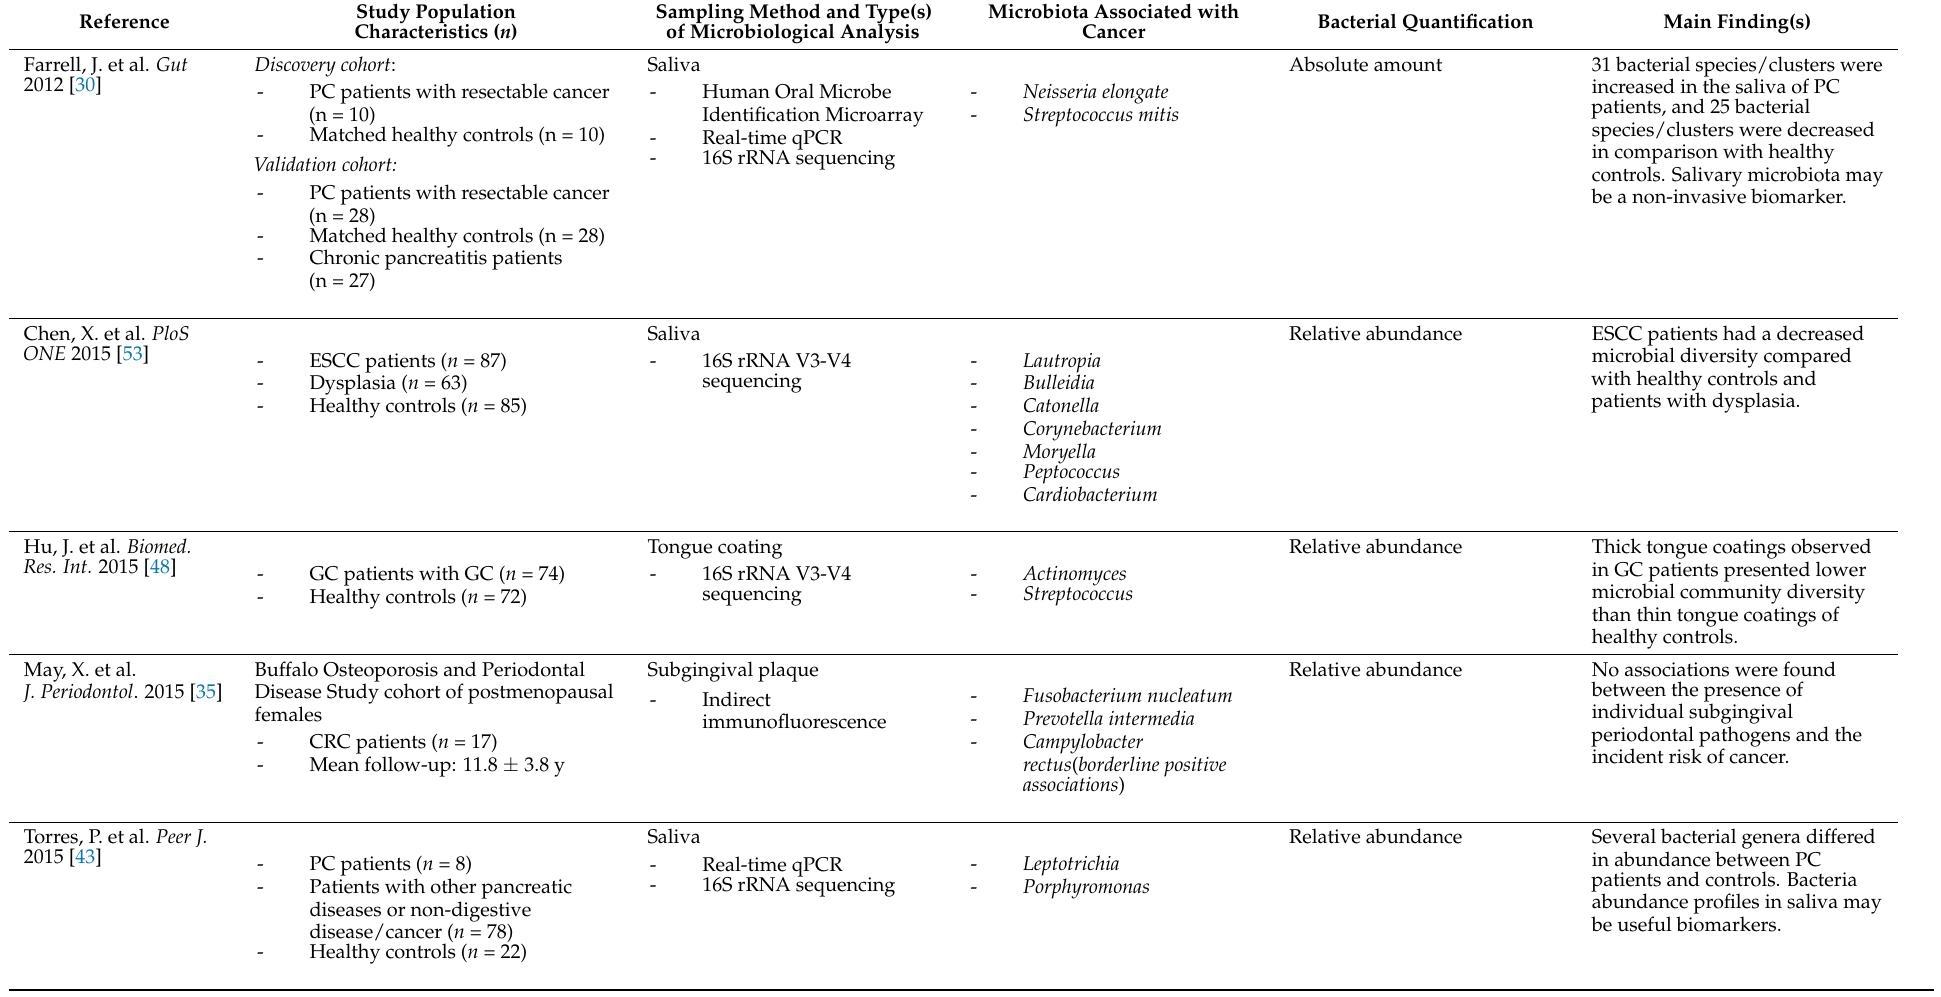
Table 2. Outcomes of the selected studies investigating the association between oral microbiota and digestive